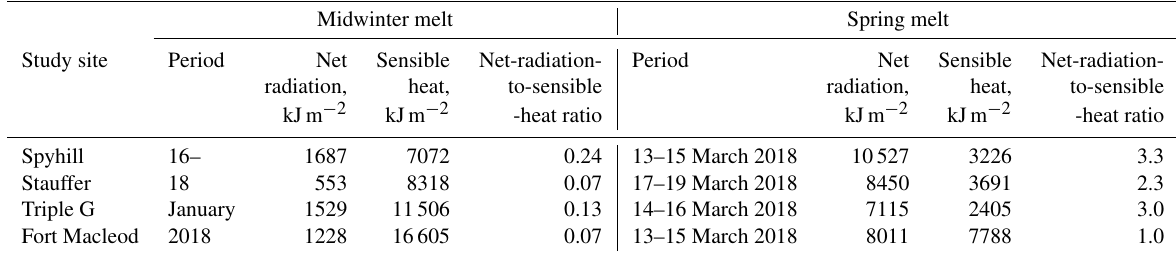
Figure 6. Daily sensible and latent heat fluxes in winter 2015–2016 (a, b) and in winter 2016–2017 (c, d) . Positive values indicate fluxes towards the surface. Arrows indicate midwinter snowmelt events at one or more study sites. Shaded areas in (c, d) indicate events shown in Fig. 7. Table 4. Sum of positive net radiation and sensible heat inputs during midwinter and spring melt events. Periods start and end at noon on shown